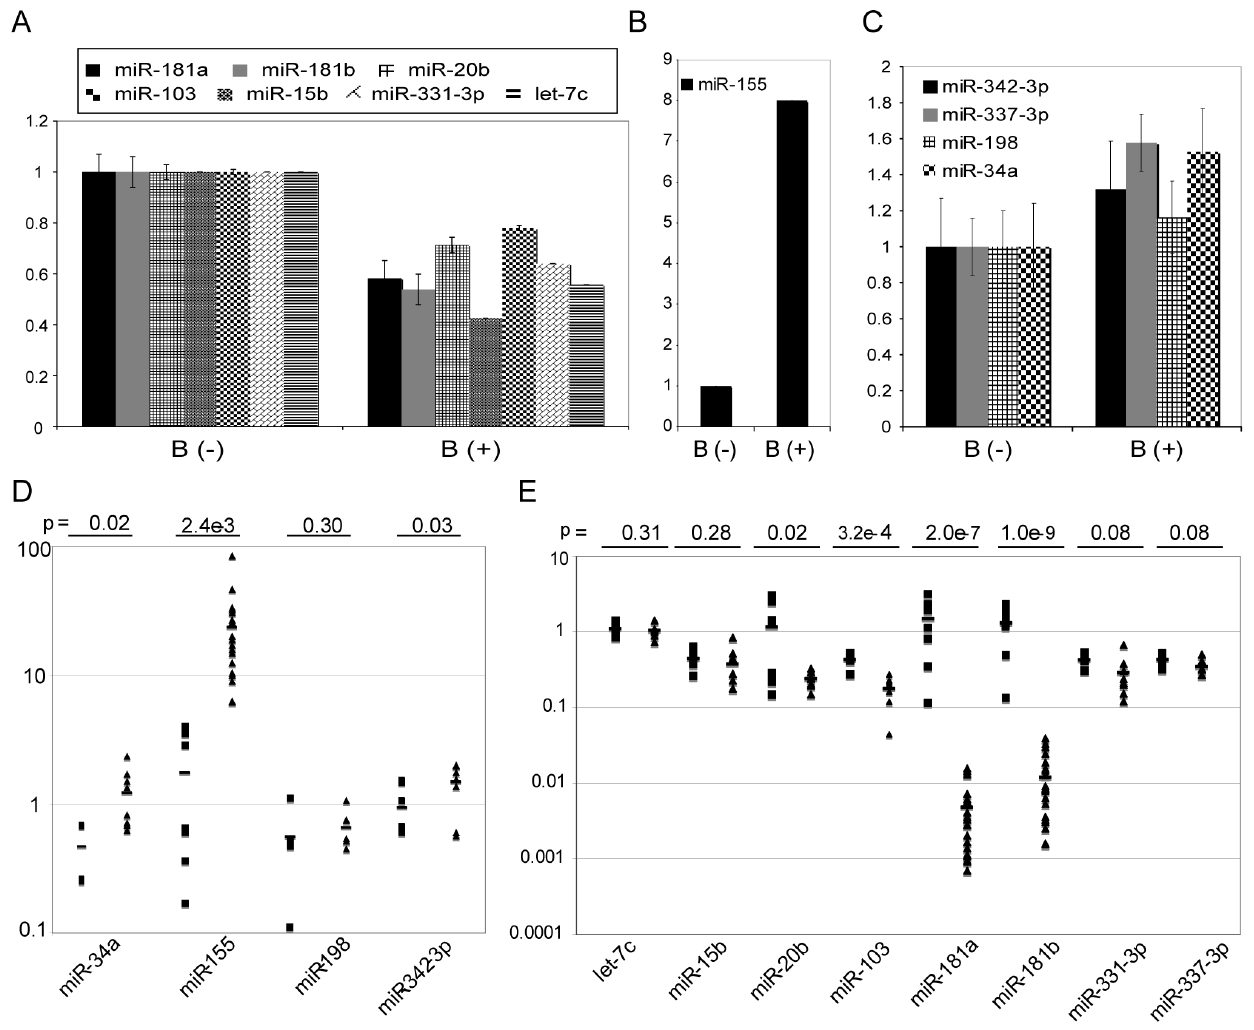
Figure 2. Validation of altered miRNA expression identified by GSEA. miRNA-specific RT-PCR independently confirms altered expression of GSEA-identified miRNAs in B cells activated with CpG. A. miR-181a, miR-181b, miR-20b, miR-103, miR-15b, miR-331-3p, and let-7c. B. miR-155. C. miR- 342-3p, miR-337-3p, miR-198, and miR-34a. For (A, B, C), B (-): control B cell samples. B ( + ): corresponding activated B samples by CpG. Error bars indicate the standard deviation of 3 independent samples. D, E. miRNA-specific RT-PCR confirms the differential expression of subsets of GSEA- identified miRNAs in CLL relative to control B cells. Upregulated miRNAs are miR-34a, miR-155, miR-198 and miR-342-3p. Downregulated miRNA expression including let-7c, miR-15b, miR-20b, miR-103, miR-181a, miR-181b, miR-331-3p and miR-337-3p. Between 4 to 8 control unstimulated B cell samples (square) and between 6 to 21 CLL patient samples (triangle) were used. The bar indicates the average expression in each group. p -value for the analysis calculated by t-test is shown. miRNA expression was normalized by snoRNA-RNU44 expression. Relative miRNA expression was calculated by DD Ct method and is indicated on the Y-axis.